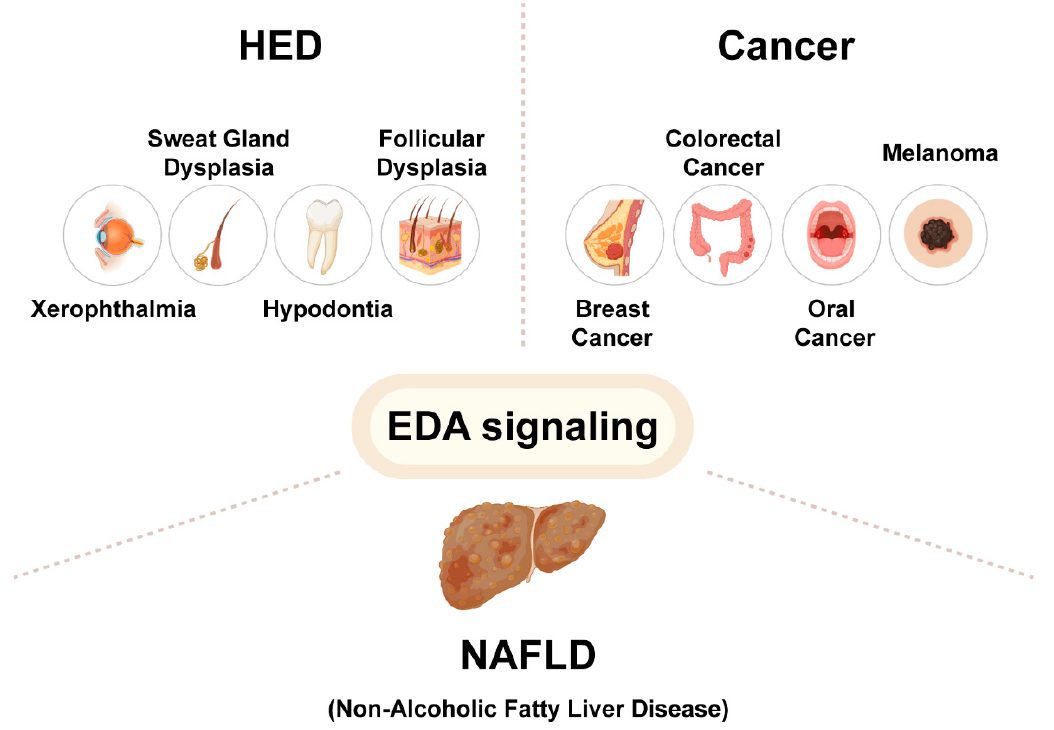
Figure 2. The EDA pathway involved in the pathogenesis of HED, cancer, and NAFLD. Gene mutations in the EDA pathway lead to hypohidrotic ectodermal dysplasia (HED), with clinical symptoms including xerophthalmia, sweat gland dysplasia, hypodontia, and follicular dysplasia. EDA signaling is also involved in tumorigenesis and cancer progression of breast cancer, colorectal cancer, oral cancer, and melanoma. In addition, EDA, as a newly discovered hepatocyte factor, may be highly involved in the pathogenesis of nonalcoholic fatty liver disease (NAFLD).